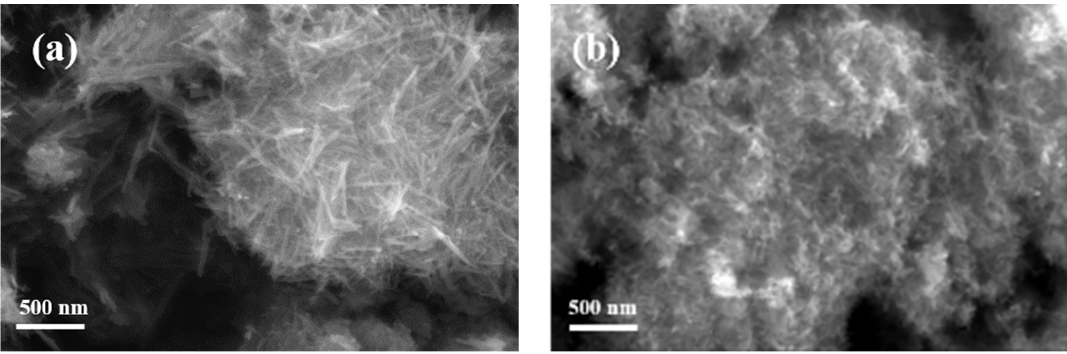
Figure 4. SEM images of ( a ) OMS-2 and ( b ) 5Ni/OMS-2.